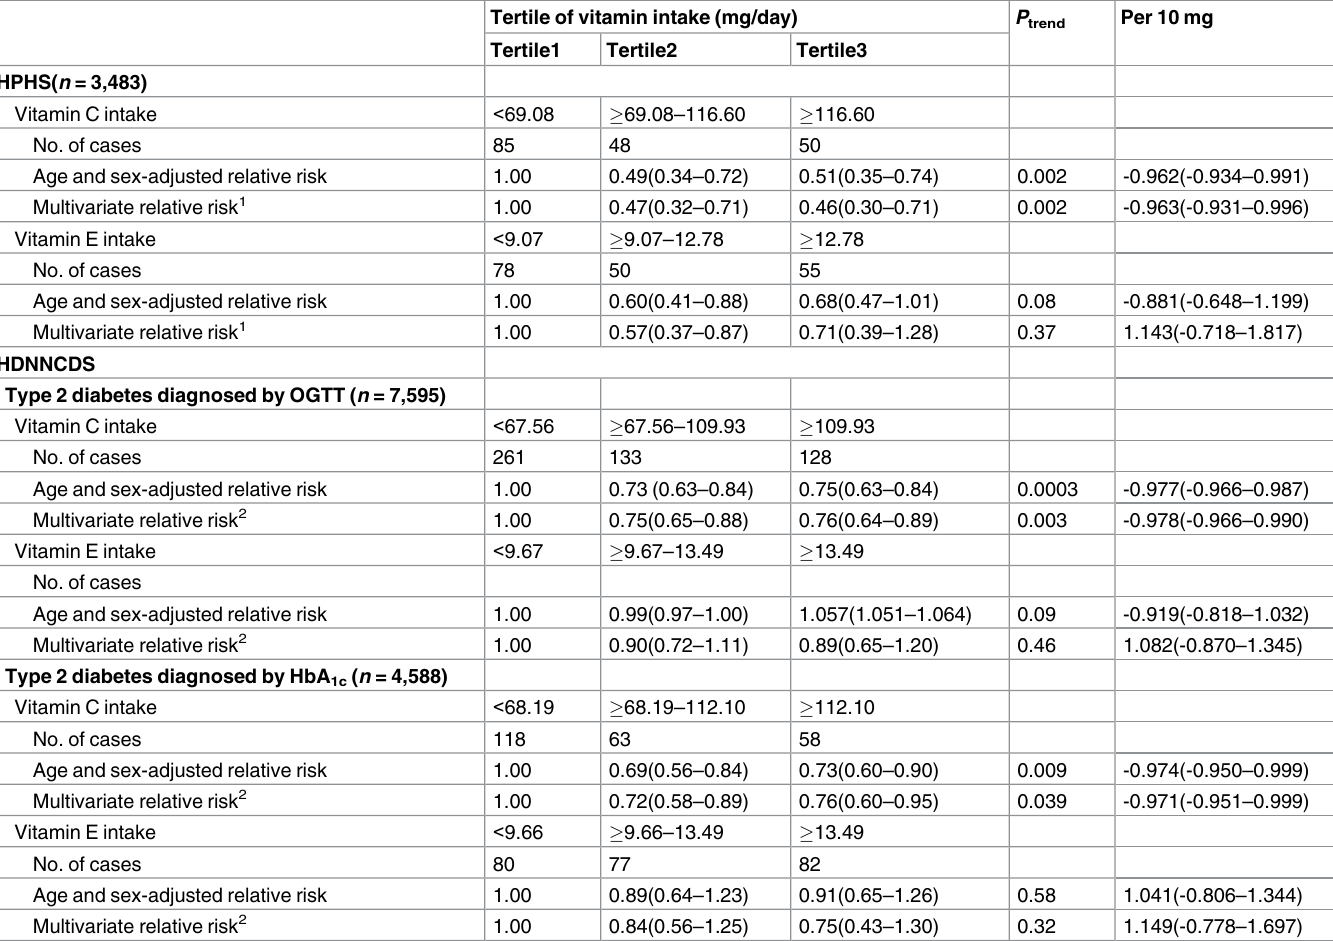
Table 2. Adjusted relative risks (RRs) (and 95% confidence interval) of type 2 diabetes diagnosed by the oral glucose tolerance test or haemoglo- bin A 1c (HbA 1c ) across tertiles of dietary vitamin C intake, the Harbin People’s Health Study (HPHS, 2008–2012) and in the Harbin Cohort Study on Diet, Nutrition and Chronic Non-communicable Diseases(HDNNCDS,